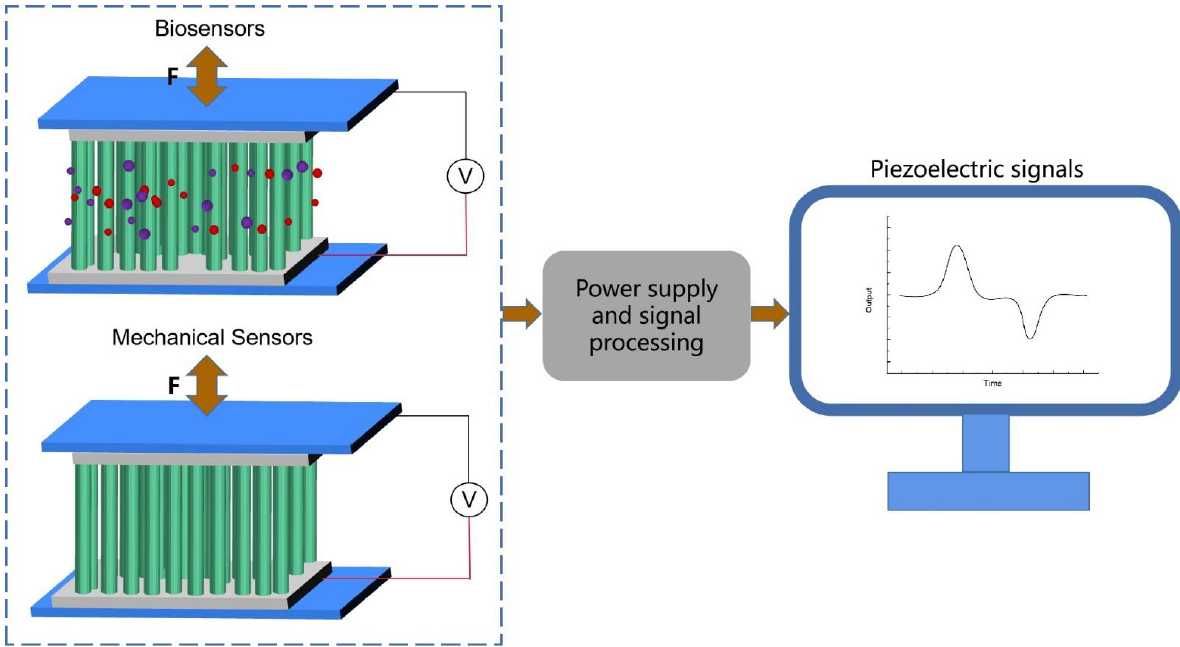
Figure 3. Sensing mechanism of PENG-based sensors, V is the voltmeter, F is the force. One type of sensing is mechanical, monitoring motions, the respiratory rate, and